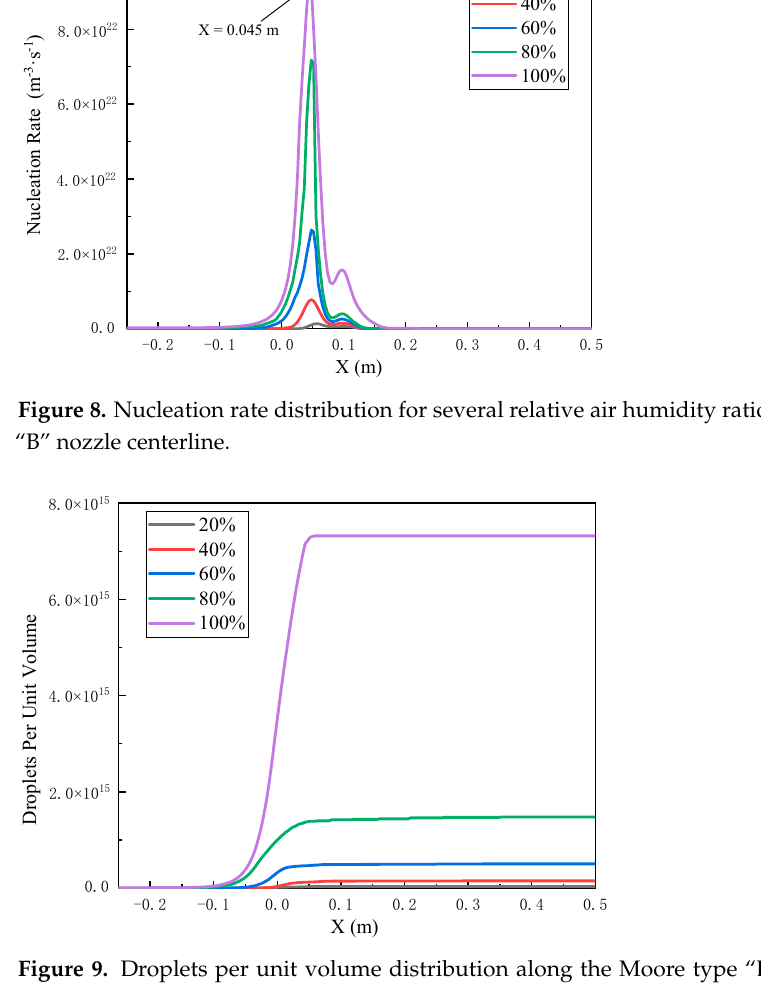
Figure 10. Liquid mass fraction distribution along the Moore type “B” nozzle centerline for several relative air humidity levels.